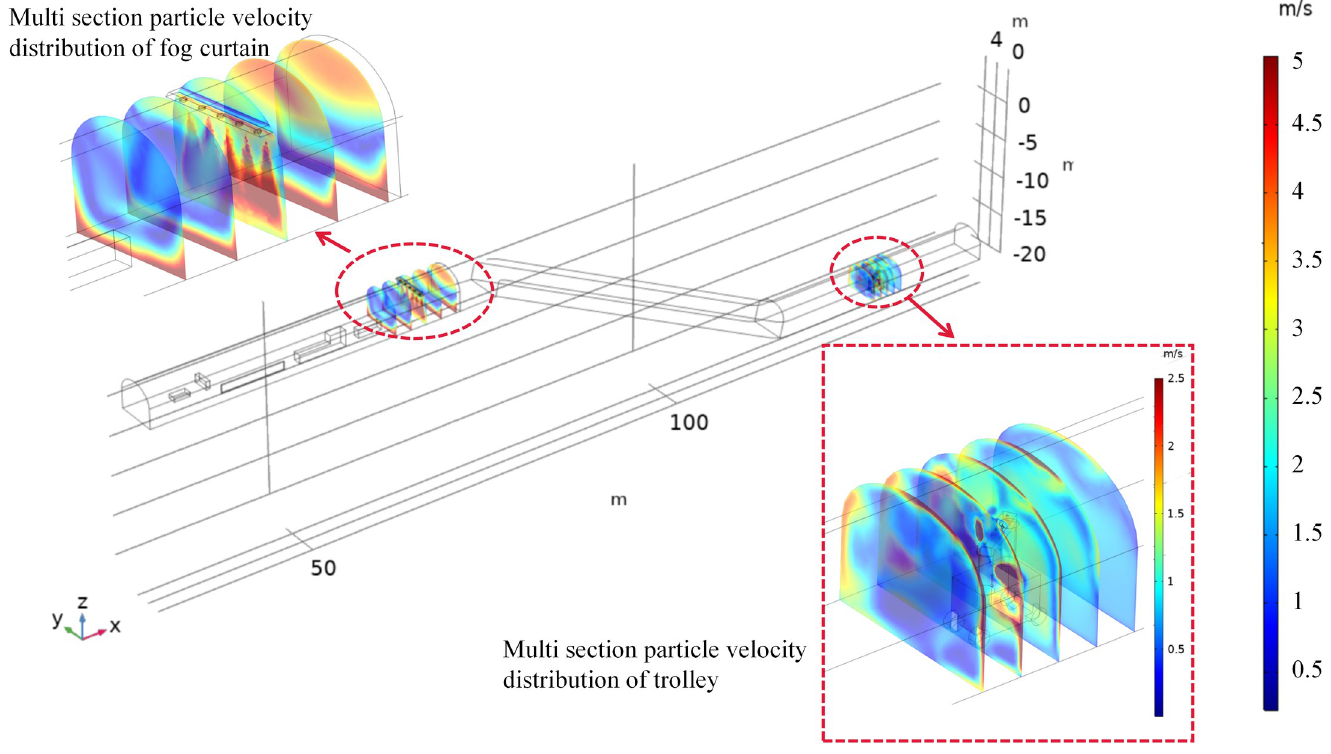
Fig 11. Droplet velocity distribution